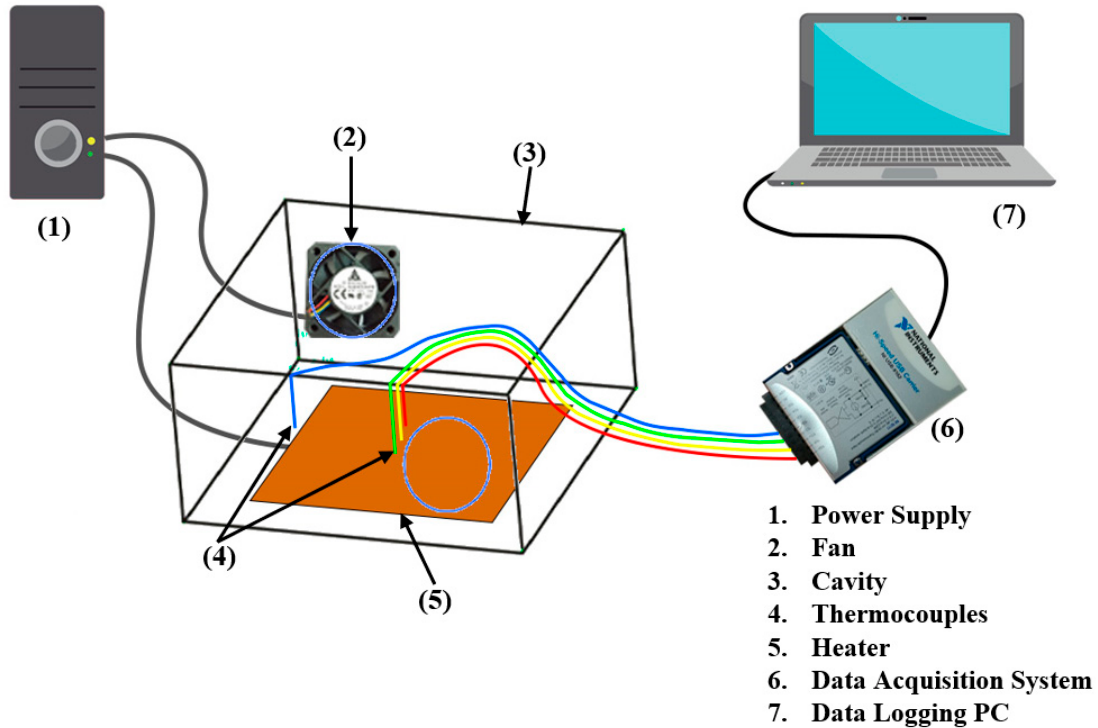
Figure 2. Schematic representation of the setup.